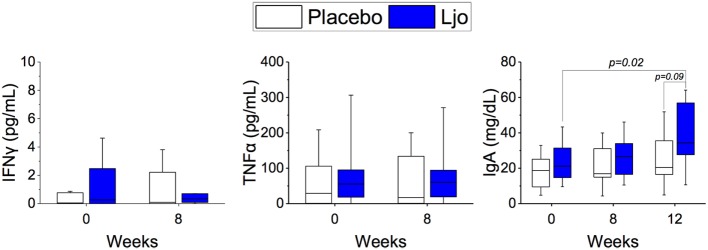
Determination of soluble markers. The concentrations of IFNγ, IgA, and TNFα were quantified in the placebo (white bars) and L. johnsonii N6.2 (Ljo, blue bars) group at time 0 and after 8 weeks of treatment or after the washout (12 weeks).